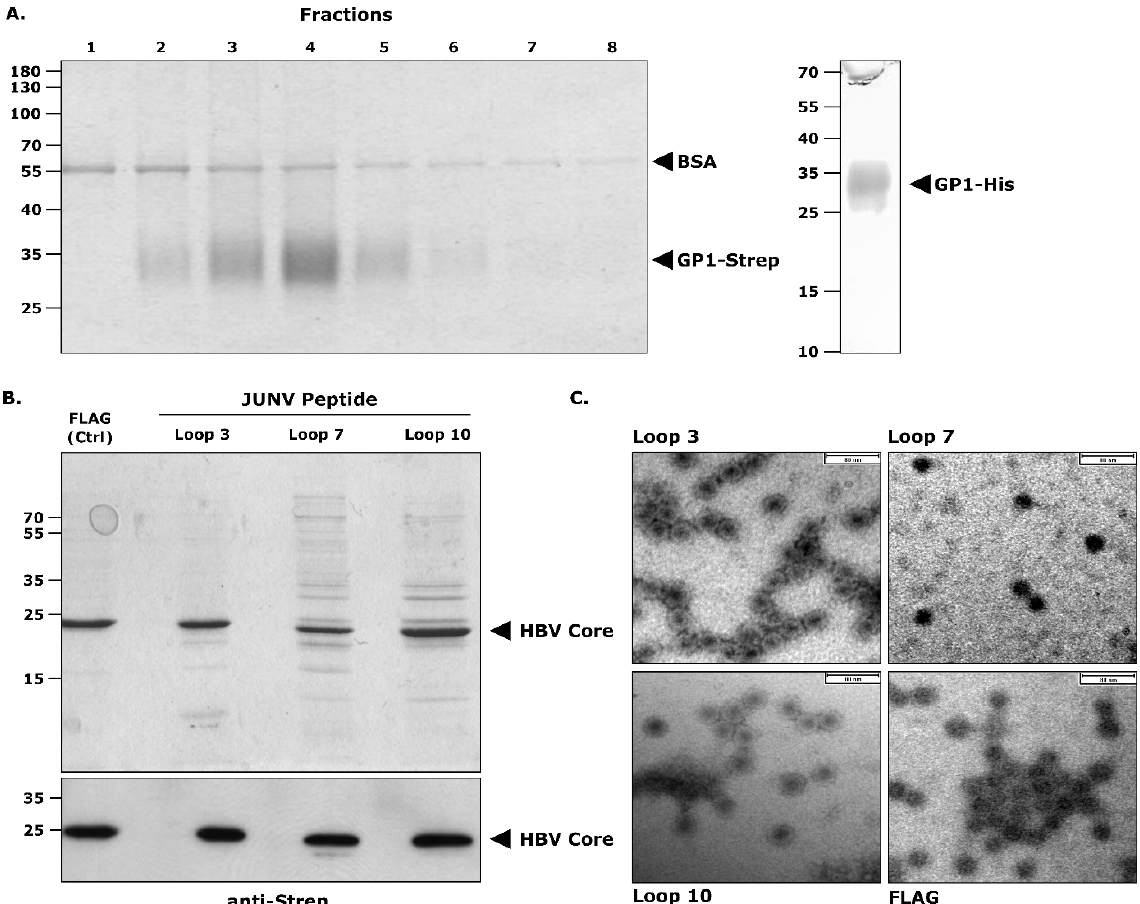
Figure 2. Preparation of antigens for immunization. ( A ) Purification of recombinant Junín virus (JUNV) GP1. JUNV GP1 containing a C-terminal Strep tag (GP1-Strep) was transiently expressed in